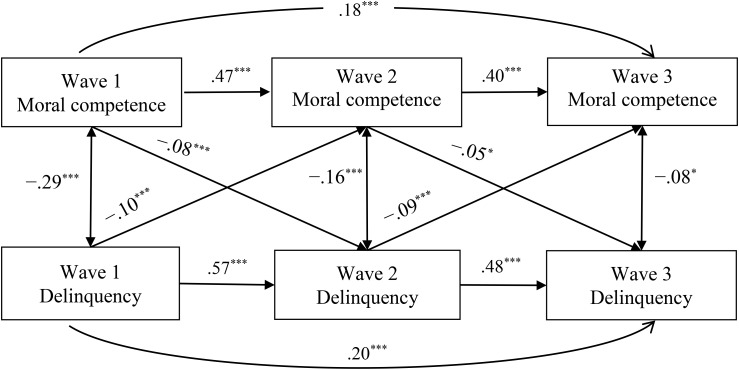
Standardized path coefficients for the reciprocal associations model between moral competence and delinquency. χ2(2) = 2.52, p = 0.28, CFI = 0.99, IFI = 0.99, TLI = 0.99, RMSEA = 0.011. ∗p < 0.05, ∗∗p < 0.01, ∗∗∗p < 0.001.